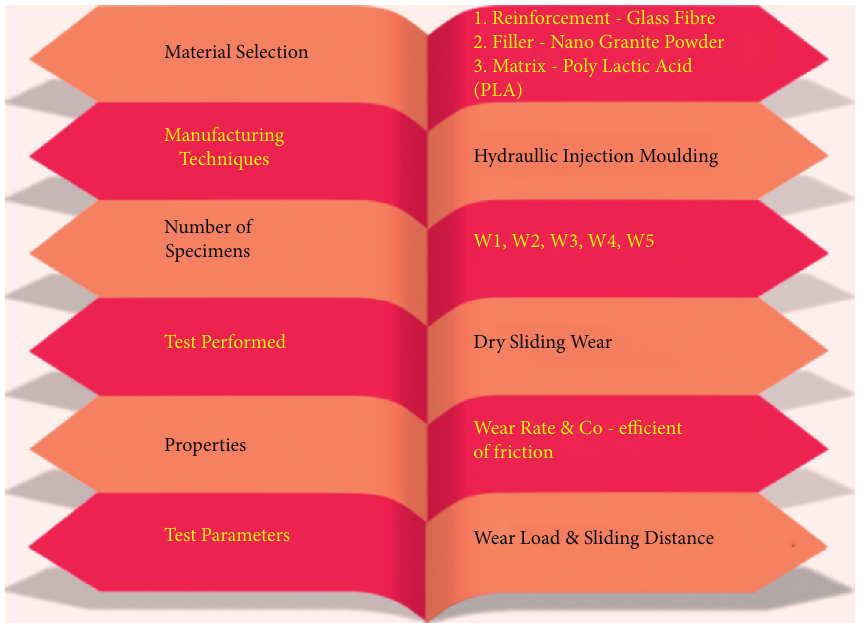
Figure 4: Overview of this experimental work. Table 1: The different chemical compositions of glass fibre in wt.